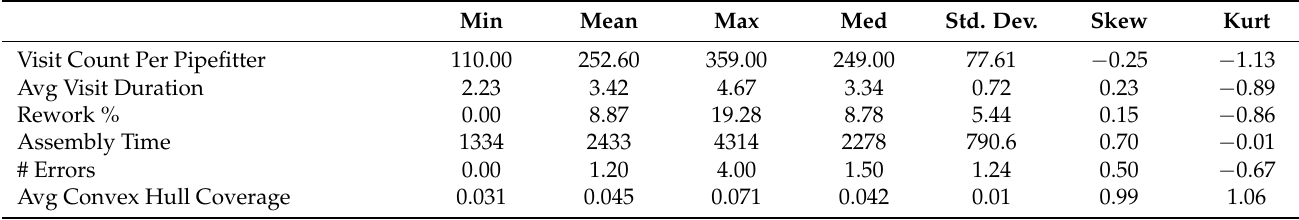
Table 4. Descriptive statistics—pipefitters (N =